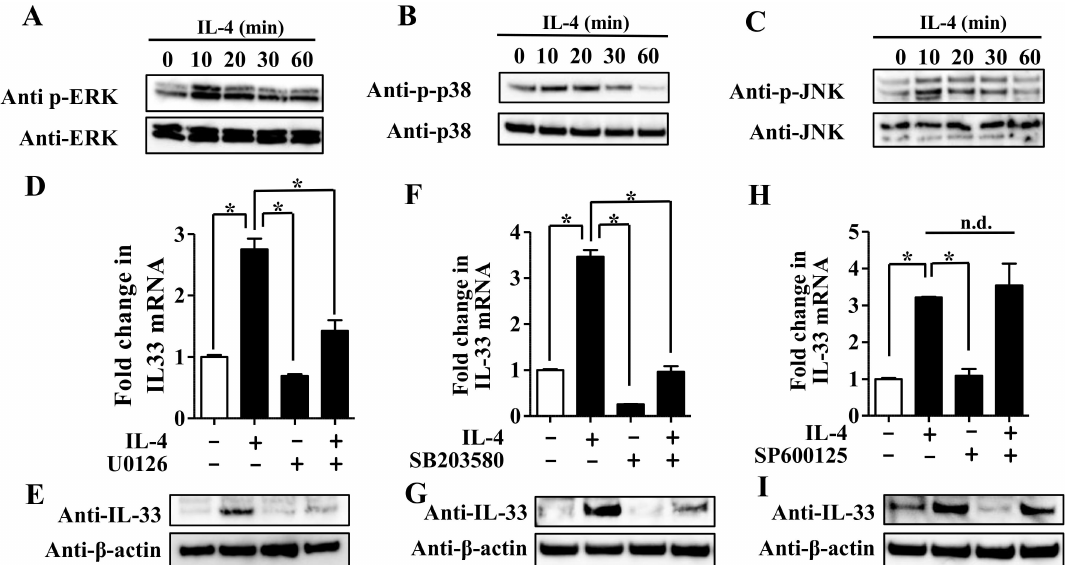
Figure 3. ( A – C ) NHEKs were treated with IL-4 (10 ng / mL) for the indicated period. Total cell lysates were prepared and subjected to Western blotting analysis with an anti-phosphorylated extracellular signal-regulated kinase (ERK)-1 / 2 and anti-ERK-1 / 2 antibody ( A ), anti-phosphorylated p-38 and anti-p38 antibody ( B ), or anti-phosphorylated JNK antibody and anti-JNK antibody ( C ). ( D , E ) NHEKs were treated with IL-4 (10 ng / mL) in the presence or absence of either U0126 ( D , E ), SB203580 ( F , G ), or SP600125 ( H , I ) for 24 h. ( D , F , H ) IL-33 expression was analyzed by qRT-PCR. Data are expressed as mean ± S.E.M.; n = 3 for each group. * p < 0.05. ( E , G , I ) IL-33 expression was analyzed by Western blotting with an anti-IL-33 antibody. The data are representative of experiments repeated three times with similar